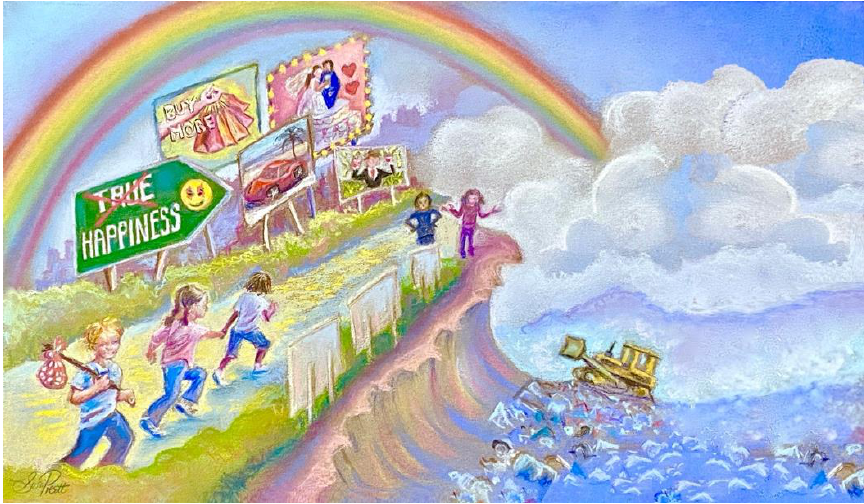
Figure 3. Collective narcissism encourages unrealistic beliefs and wasteful demand for continuous validation through superficial rewards to protect underlying fragility—ultimately with disillusion- ment, diminished life satisfaction and wellbeing, unhealthy social relationships, and relationships with nature (artwork by author, S.L.P).